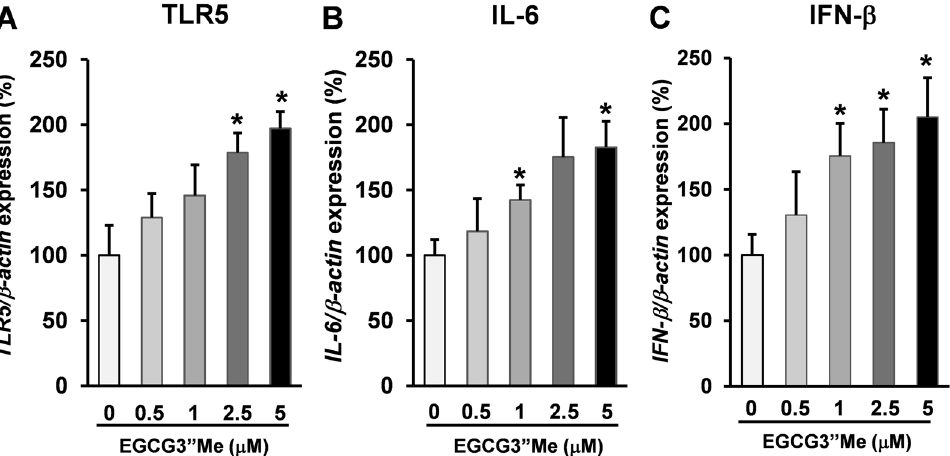
Figure 2. EGCG3”Me upregulated TLR5 expression on splenocytes. ( A – C ) Female BALB/c mice were sacrificed and the spleens were harvested. Splenocytes were seeded at 2 × 10 6 cells/mL in 10% FCS-RPMI-1640 medium in 12-well plates and treated with different doses of EGCG3”Me for 24 h. After treatment, cells were harvested and the mRNA expression was evaluated by RT-qPCR. ( A ) TLR5 (n = 4), ( B ) IL-6 (n = 4), ( C ) IFN- beta (n = 4). Data are presented as means ± SEM * P < 0.05 (vs